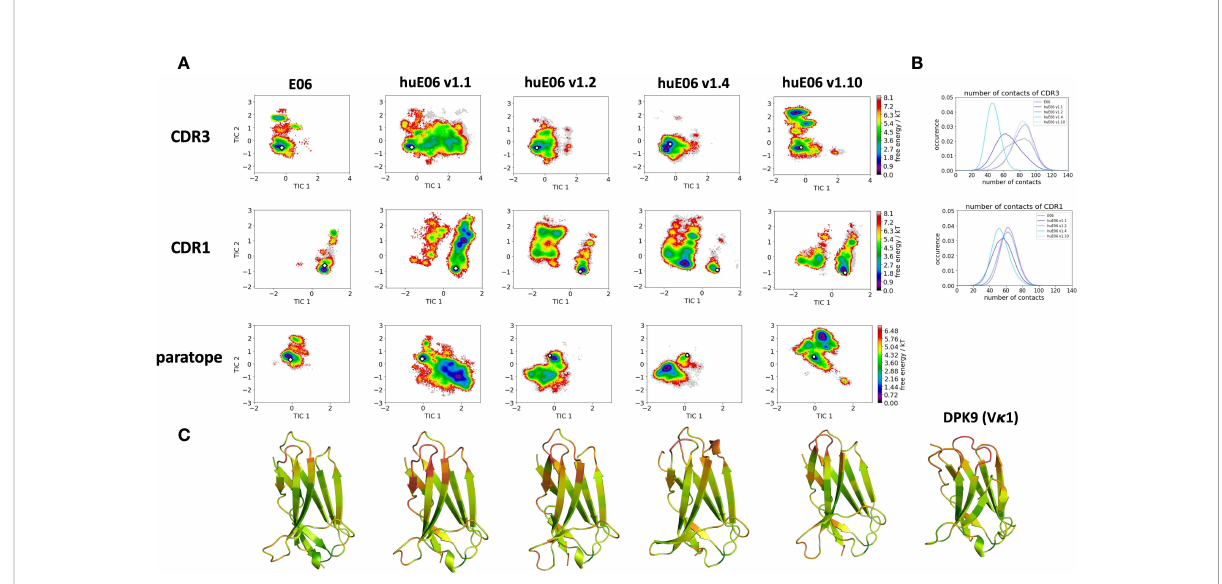
FIGURE 3 Free energy landscapes of the CDR1, CDR3 and the paratope (CDR1, CDR3 and HV2 loops), intradomain contact distributions of the individual CDR loops and dihedral entropies projected onto the VNAR structures as measure for fl exibility. (A) Free energy surfaces of the CDR1, CDR3 and the paratope for the parent E06 VNAR and the different humanization variants in the same coordinate system, respectively. The available crystal structures are depicted as white diamonds, while the models are illustrated as white circles. (B) Contacts per frame distributions of the CDR1 and CDR3 loops. (C) Residue-wise dihedral entropies mapped onto the respective structures (red – high fl exibility, green – low fl